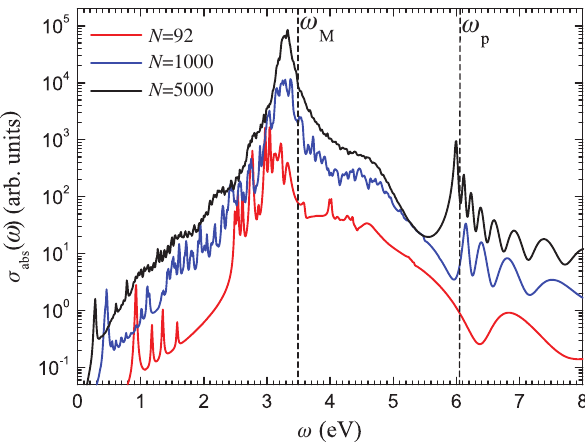
Figure 1: ALDA absorption cross section in arbitrary units for spheri- jellium clusters of radius R . Red line: N = 92 ( R = 0.94 nm); cal Na N blue line: N = 1000 ( R = 2.08 nm); black line: N = 5000 ( R = 3.55 nm). The bulk plasmon frequency, ω , and classical Mie dipole surface p / 3, ω ω = are indicated by vertical dashed plasmon frequency, M p lines. Note the logarithmic scale of the y